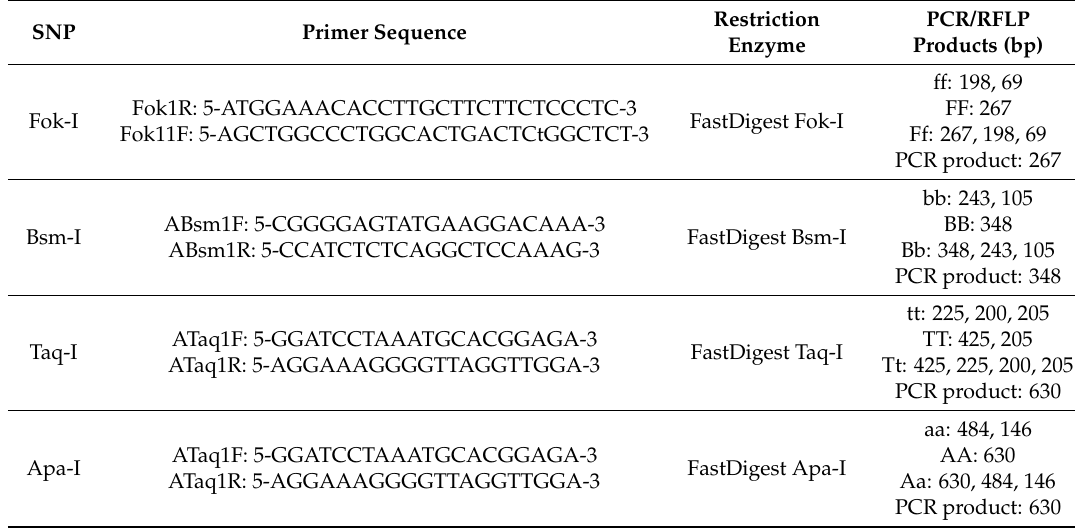
Table 1. Primers for VDR SNPs and PCR-RFLP